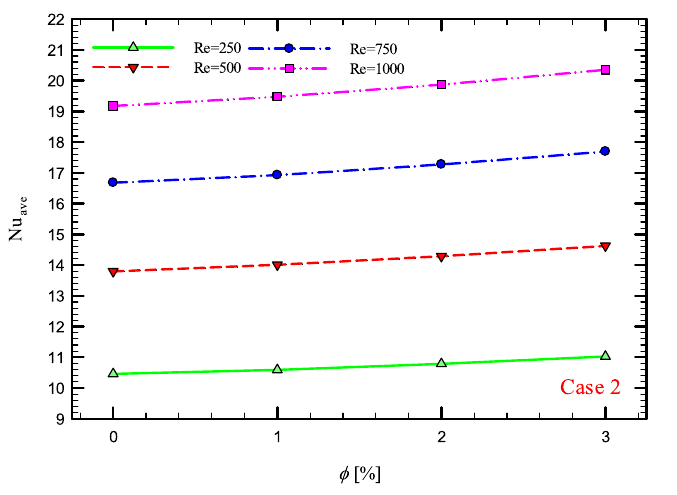
Figure 22. Nu ave versus φ for Case 2.